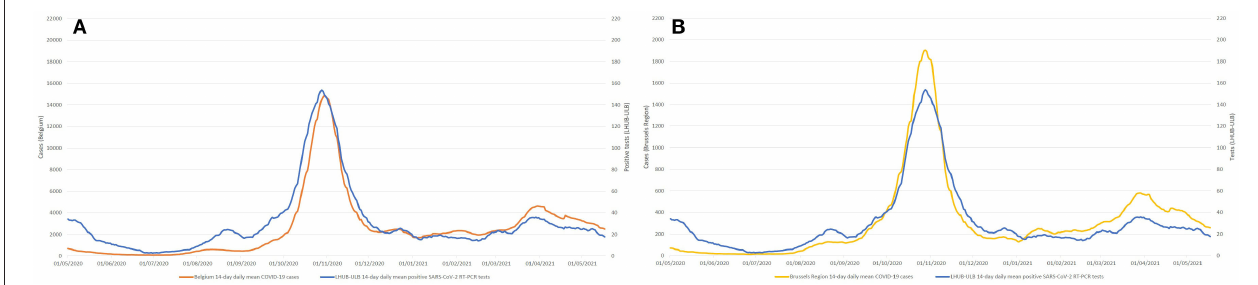
FIGURE 3 | Compared evolution of 14-day mean number of positive SARS-CoV-2 RT-PCR tests (LHUB-ULB) with Belgium (A) and Brussels (B) 14-day mean COVID-19 cases.